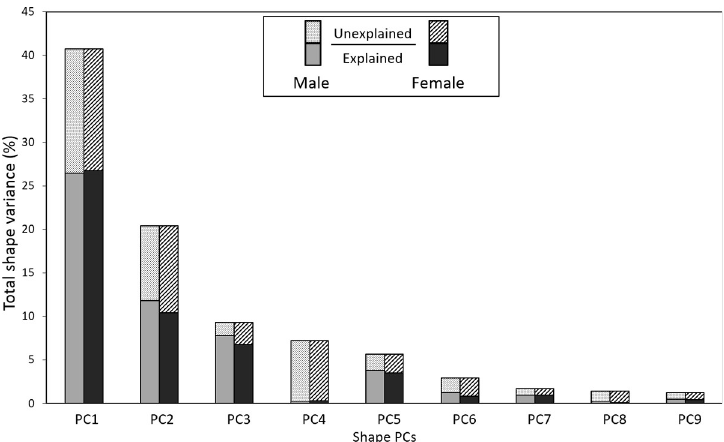
Fig 9. Proportions of total torso shape variation within LIFE dataset explained and unexplained by each torso shape PC for males and females.